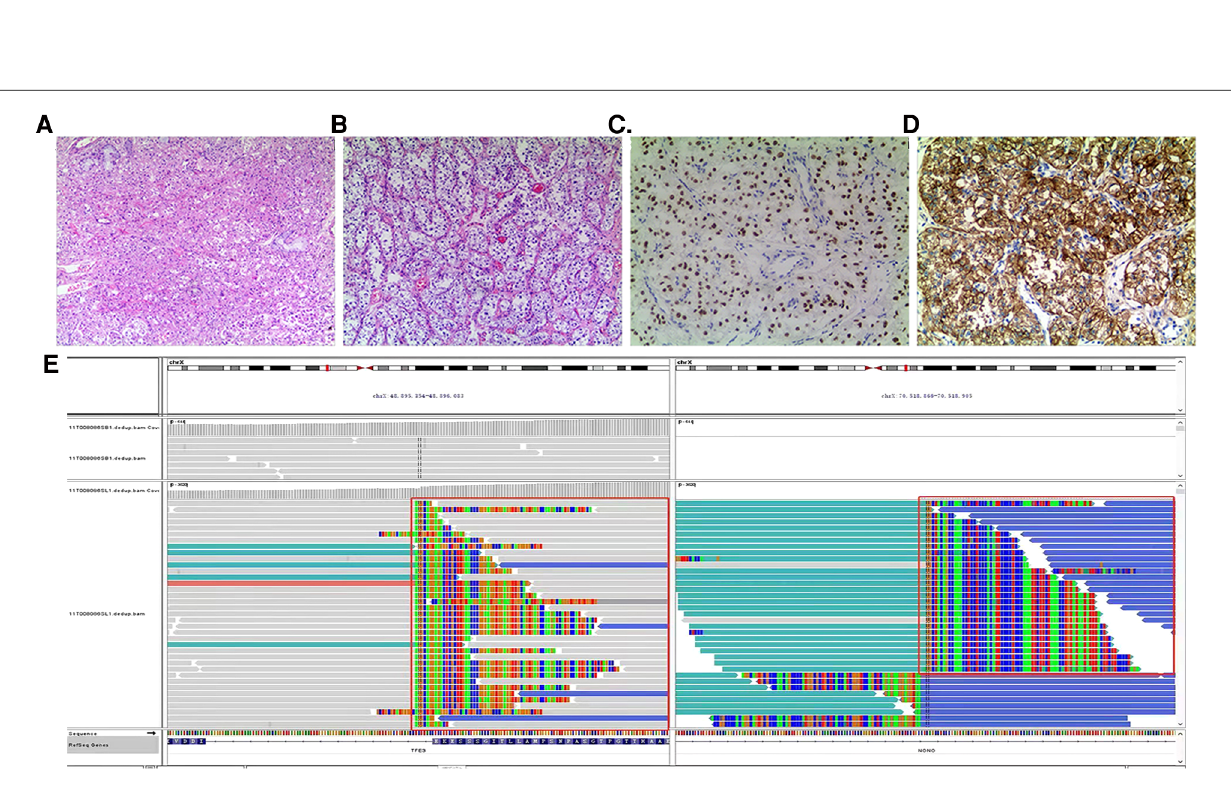
FIGURE 2 ( A,B ) (HE staining ×100) Tumor cells are arranged in a nest-like and alveolar manner, with abundant cytoplasm, some of which are eosinophilic and transparent. The nuclei are round in shape with obvious nucleoli and abundant blood supply in the tumor. ( C ) (Immunohistochemical TFE3 ×200) Tumor cells TFE3 positive. ( D ) (Immunohistochemical CD56 ×200) The cytoplasm and membrane of tumor cells positive. ( E ) (Next-generation sequencing) TFE3 rearrangement, ASPSCR1 – TFE3